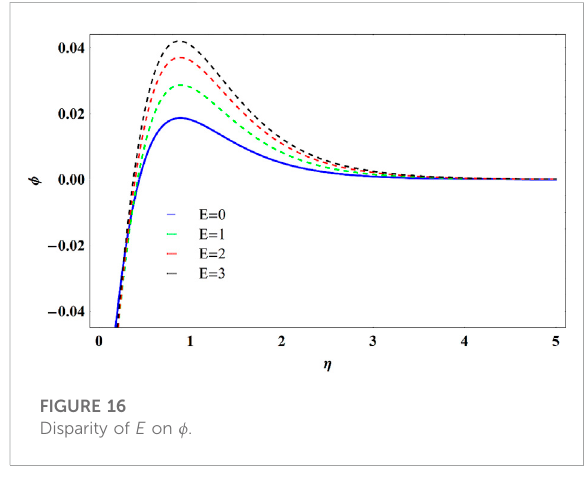
FIGURE 19 Disparity of Sc on ϕ